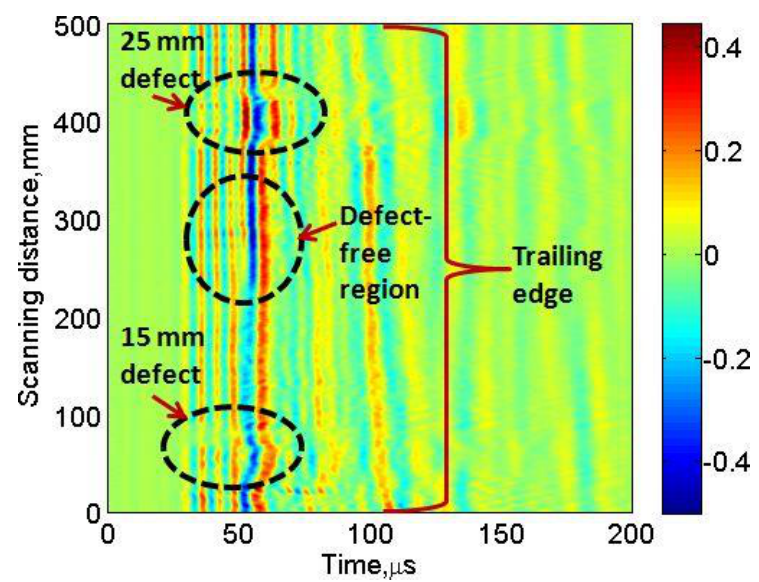
Figure 5. The B-scan image showing the disbond type defects of 15 mm and 25 mm diameter.